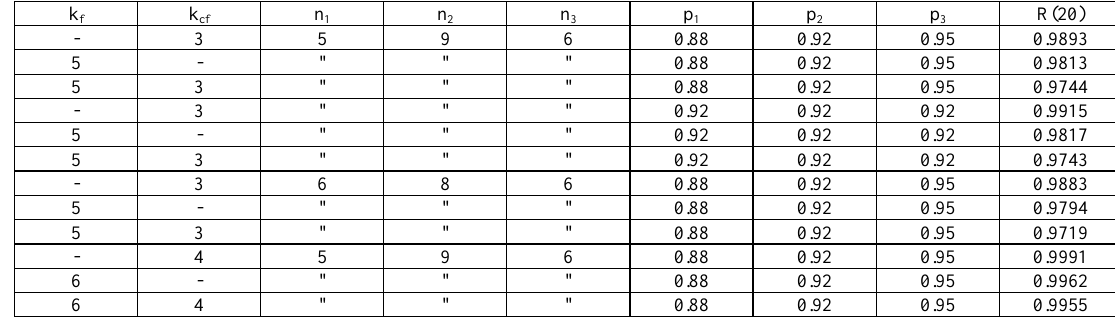
Table 3. R (F) (20), various values of n 1 , n 2 , k f ,k cf .